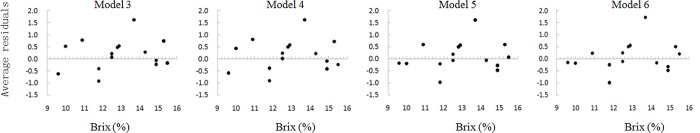
Distribution of residuals for predicting the sugar content.